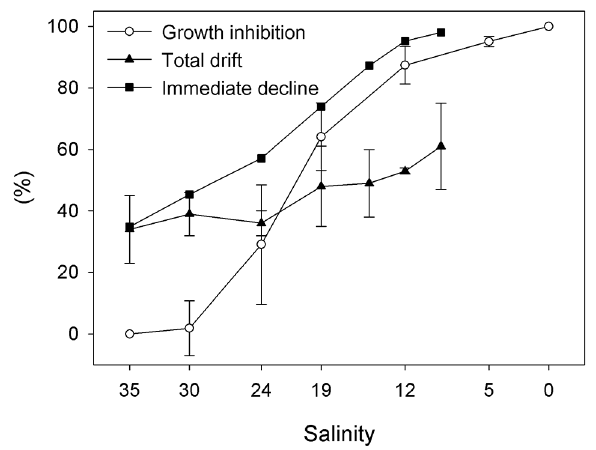
Figure 2. Mean percentage of growth inhibition (n = 3), total drift (n = 4) and immediate population decline of the benthic microalgae Cylindrotheca closterium exposed to different salinities. Data of immediate decline represent the sum of 12-h drift percentages and 72-h growth inhibition percentages of the remaining cells. Error bars indicate + 1 standard deviation. Statistical differences in responses relative to the control are indicated by * (p<0.05) and ** (p<0.01) according to the Dunnett’s